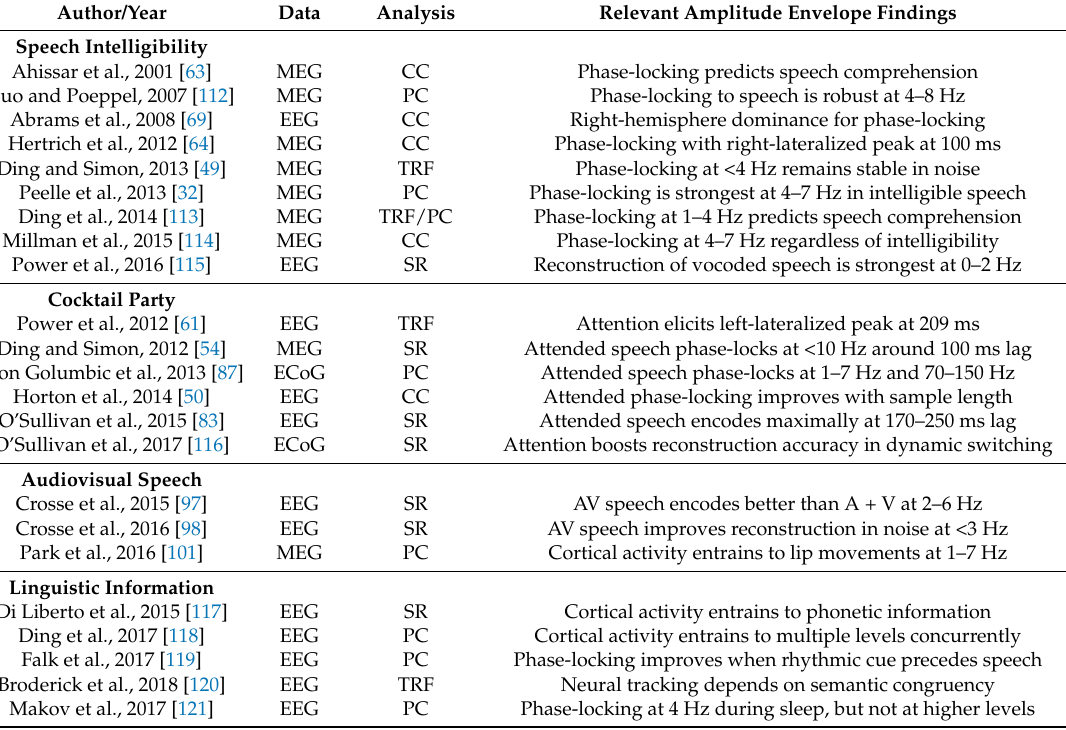
Table 1. List of papers investigating speech envelope tracking using various analysis approaches, data collection procedures, and topics of interest. Analysis abbreviations: CC—cross-correlation; PC—phase coherence; TRF—temporal response function; SR—stimulus